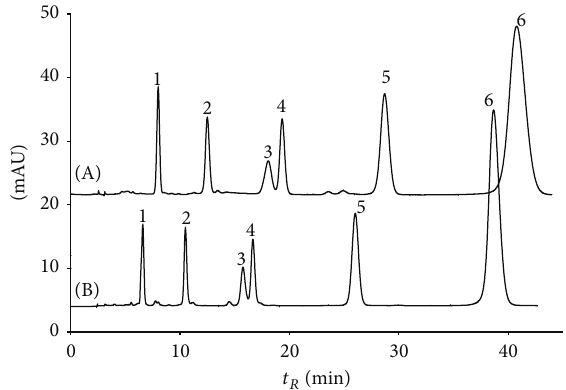
Figure 4: Separation of 3-glucosides of Dp3Glu (1); Cy3Glu (2); Pt3Glu (3); Pg3Glu (4); Pn3Glu (5); and Mv3Glu (6) in mobile phases0.5 vol.%ofH 3 PO 4 and9 vol.%ofacetonitrile(A)and10 vol. % of HCOOH and 6vol. % of acetonitrile (B), 1mL/min; detection at